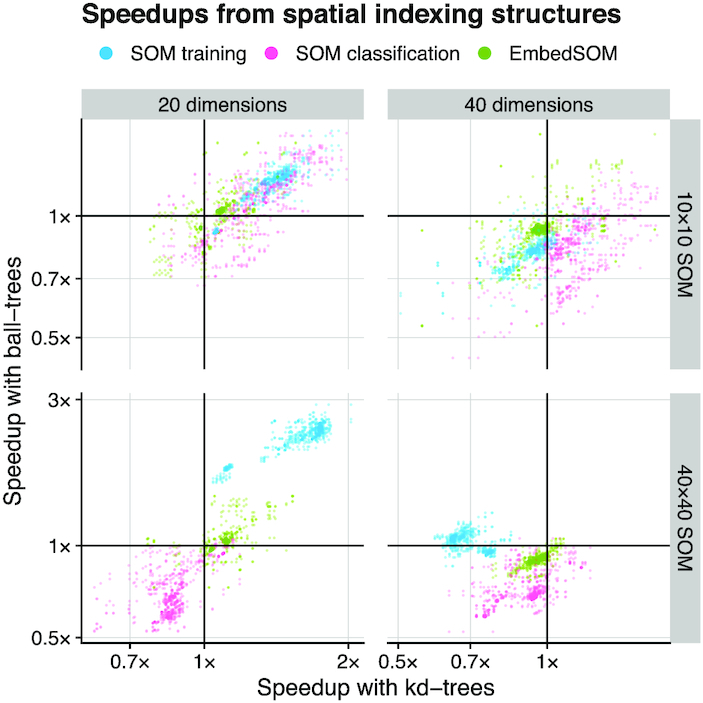
Effect of data-indexing structures on GigaSOM performance. The plotted points show relative speedup of the algorithms utilizing kd-trees (horizontal axis) and ball-trees (vertical axis) compared with brute-force neighbor search. Baseline (1× speedup) is highlighted by thick grid lines—a point plotted in the upper right quadrant represents a benchmark measurement that showed speedup for both kd-trees and ball-trees, upper left quadrant contains benchmark results where ball-trees provided speedup and kd-trees slowed the computation down, etc.